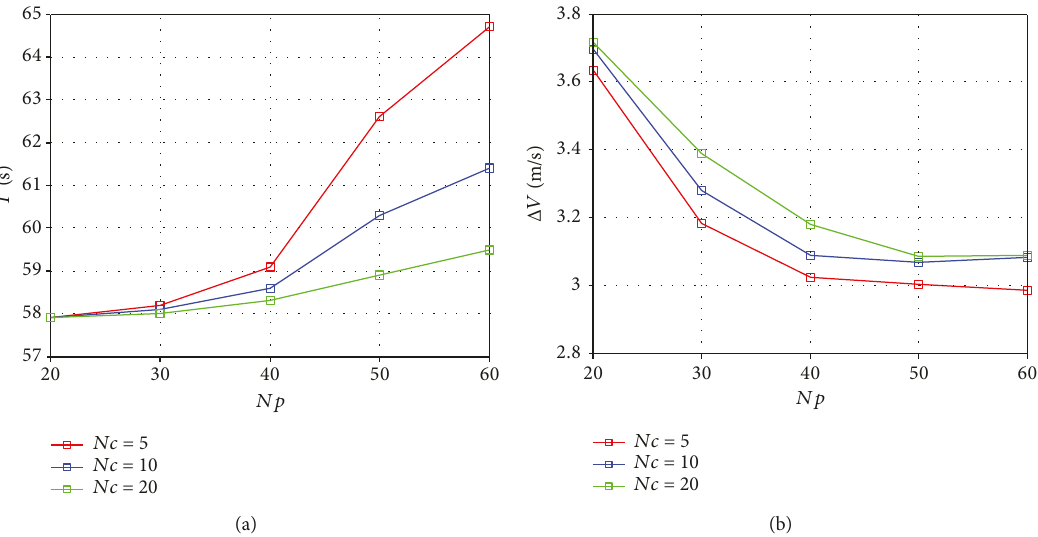
Figure 9: In fl uences of the predictive horizon N